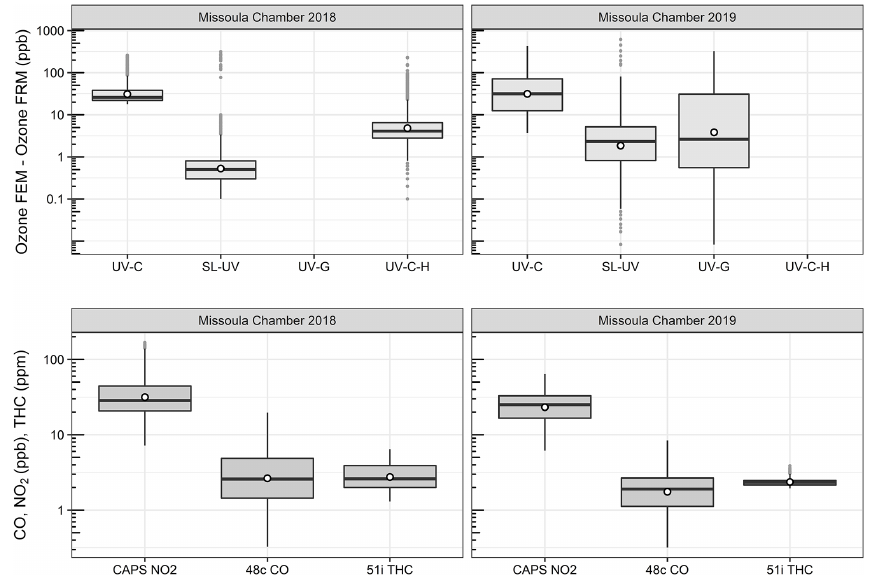
Figure 3. Differences between the FEM and FRM instrument concentrations (FEM − FRM) and NO 2 , CO, and total hydrocarbon (THC) concentrations during the 2018 and 2019 Missoula chamber studies. All measurements included are within-smoke-only measurements and show both the elevated smoke tracers (NO 2 , CO, THC) and the persistent elevation of the FEM O 3 measurements compared to the FRM. The box-and-whisker plots indicate the 25th, 50th, and 75th quartiles, with the whiskers extending to 1.5 times the inner quartile range. The open dots indicate the mean values for each instrument within